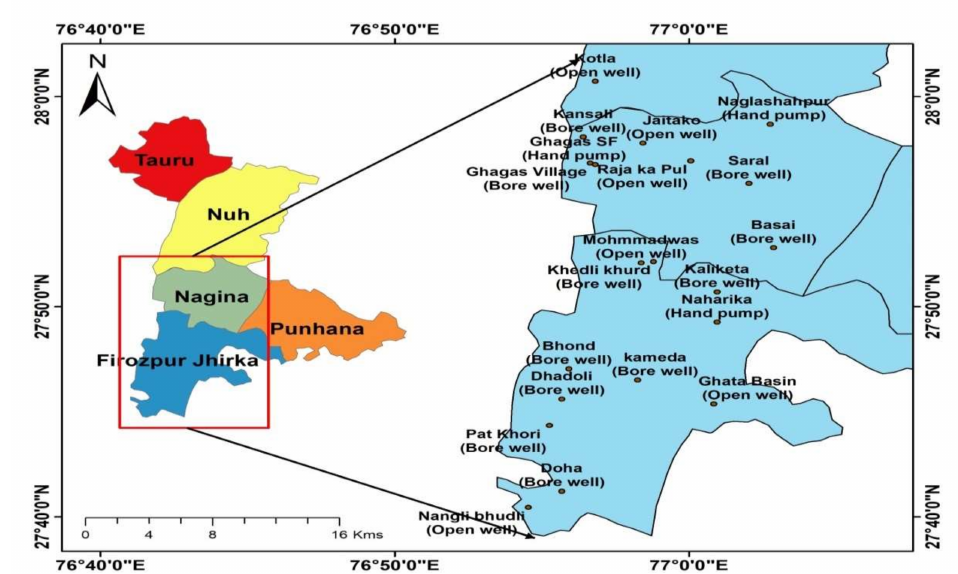
Figure 3. Sampling locations depicting sampled well